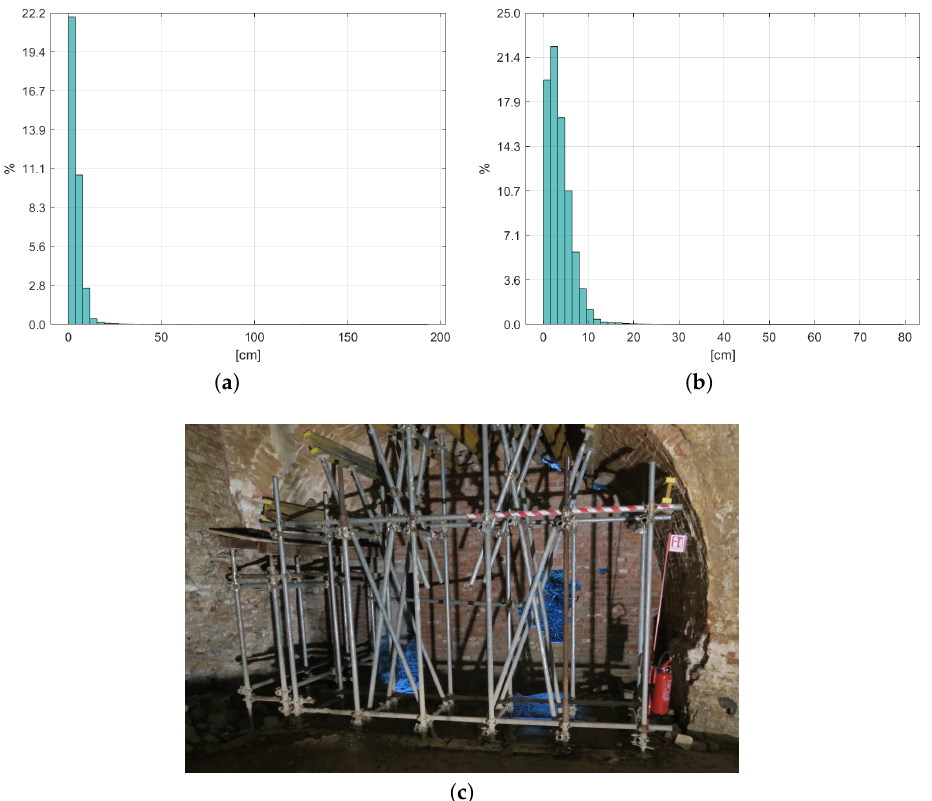
Figure 4. Leica Pegasus 3D model accuracy assessment: comparison with the TLS 3D model. Point clouds registered in local coordinates with the ICP algorithm. ( a ) Histogram of point-to-point distances between point clouds. ( b ) Histogram of point-to-point distances discarding the end part of the left wing of the bastion. ( c ) Final part of left wing of the